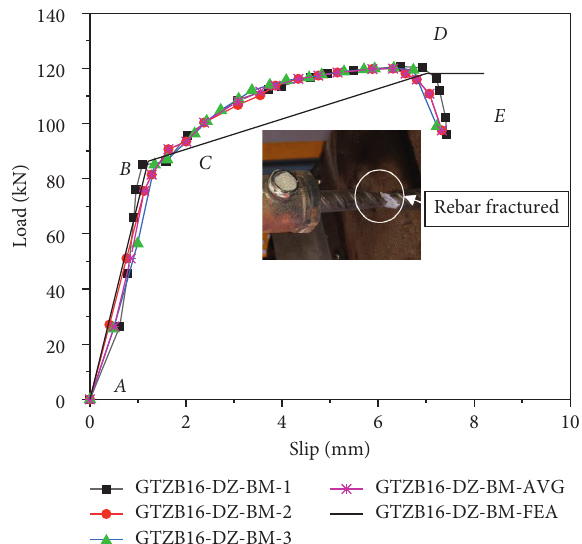
Figure 7: The load-slip curves of the control group (AVG: average value; FEA: finite element